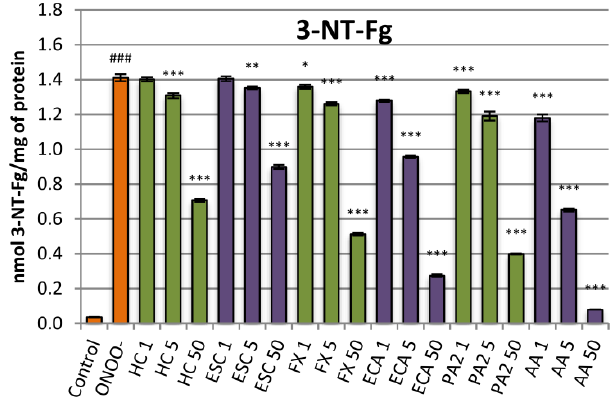
Figure 4. Effects of the investigated analytes on tyrosine nitration in the isolated fibrinogen exposed to ONOO − . Results presented as means ± SE ( n = 10). Statistical differences: ### p < 0.001 for control fibrinogen versus ONOO − -treated fibrinogen (without the investigated analytes); * p < 0.05, ** p < 0.01, *** p < 0.001 for ONOO − -treated fibrinogen in the presence of the analytes versus ONOO − - treated fibrinogen without the analytes. Analytes: HC, horse-chestnut bark extract; ESC, esculin; FX, fraxin, ECA, (-)-epicatechin; PA2, procyanidin A2; AA, ascorbic acid; the numbers after analyte symbol indicate concentration in μ g/mL.